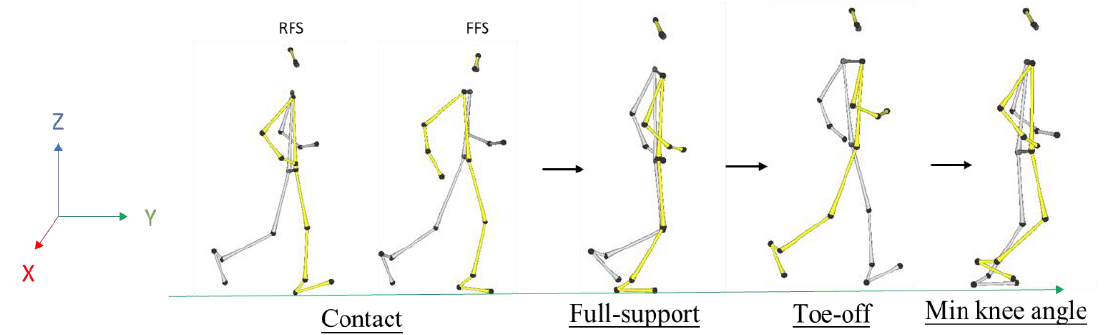
Figure 3. RFS and FFS running stages.